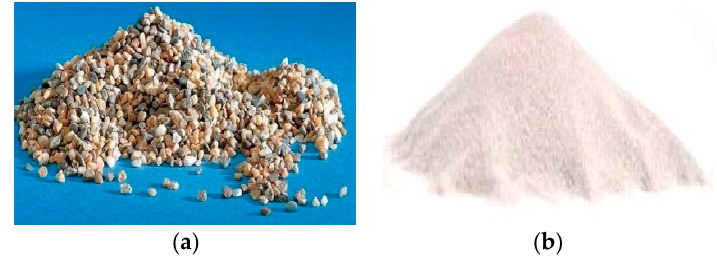
Figure 5. Materials used for the filter clogging: ( a ) fine gravel; ( b ) fine sand.